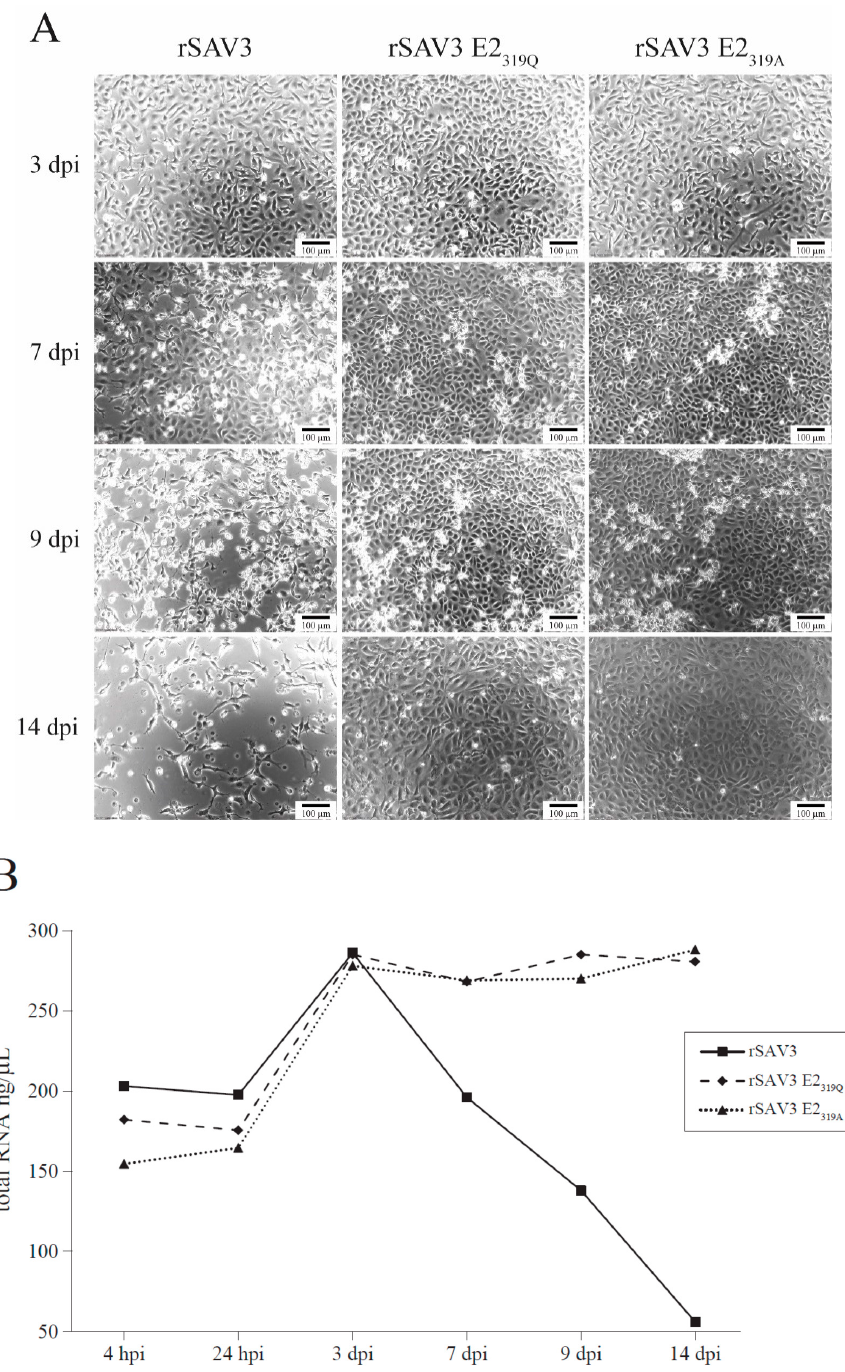
Figure 6. Cytopathic e ff ect (cpe) in CHH-1 cells infected with rSAV3, rSAV3 E2 319Q and rSAV3 E2 319A . ( A ) Cytopathic e ff ect monitored by phase contrast microscopy at 3 dpi: no cpe; 7 dpi: subtle di ff erences in wells, more rounded cells are observed for rSAV3; 9 dpi: detached cells are observed in all wells, but to a larger degree in cells infected with rSAV3 where the monolayer is partially disrupted; 14 dpi: the monolayer is completely disrupted for rSAV3, while intact for the cells infected with rSAV3 E2 319 mutants. ( B ) The total RNA (ng / µ L) in adherent cells. All wells have an increase in RNA concentration until day 3 pi. The amount of cellular RNA in rSAV3 E2 319 mutants infected cells stabilizes thereafter, while that of rSAV3-infected cells rapidly